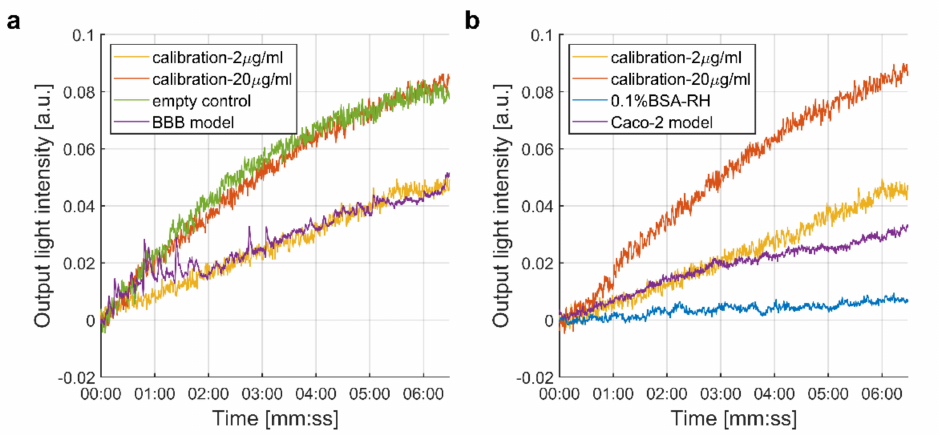
Figure 3. Results of the interferometric biosensing by the integrated optical MZI sensor. Both graphs show the signals detected after the introduction of the calibration samples (2 and 20 µ g/mL). ( a ) Results obtained from samples after the passage of the spike protein S1 subunit across cell-free cell culture inserts and the BBB model. ( b ) Signals detected from buffer (0.1% BSA-RH) or samples after the permeability of the spike protein through the Caco-2